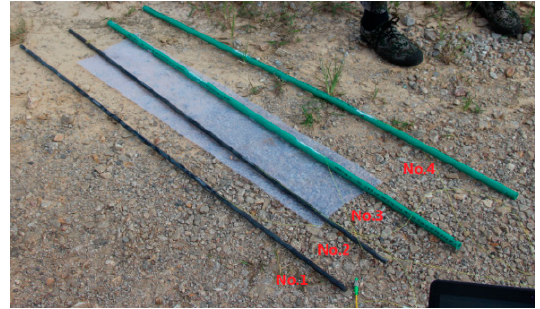
Figure 2. The four sensors used in this study (bare sensors).